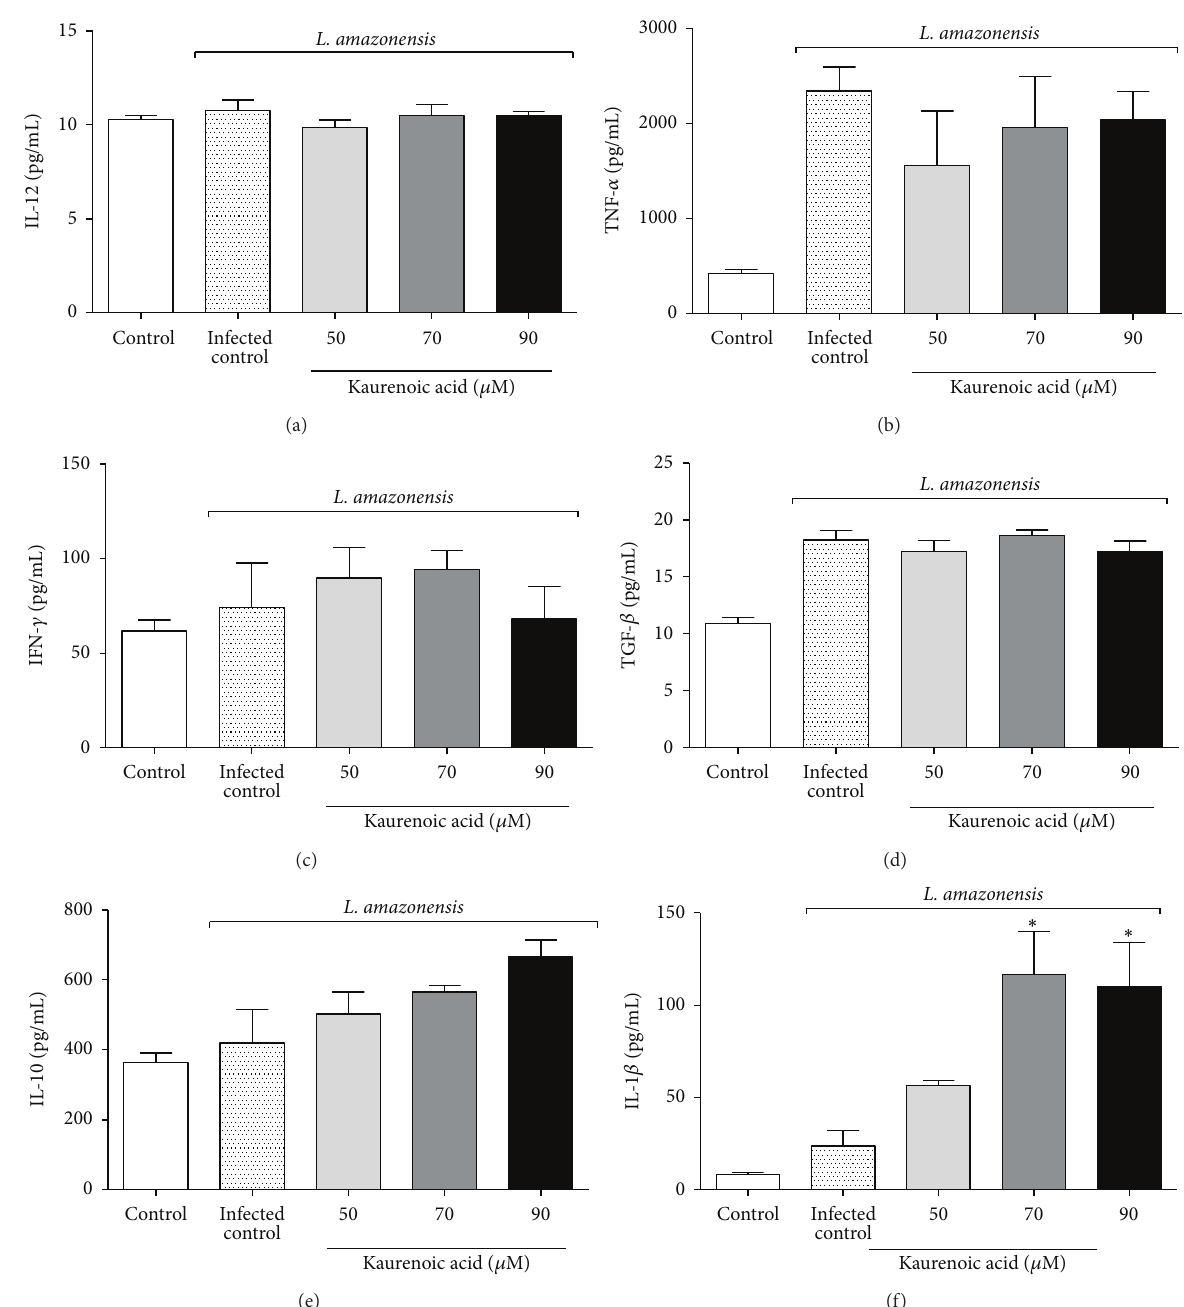
Figure 4: Kaurenoic acid promotes the production of active IL-1 𝛽 in macrophages infected with L. amazonensis . Mapping the cytokine profiling produced in vitro by macrophages infected with L. amazonensis and treated with kaurenoic acid (50, 70, and 90 𝜇 M) for 24 h determined by ELISA. IL-12 production (Panel (a)), TNF- 𝛼 production (Panel (b)), IFN- 𝛾 production (Panel (c)), TGF- 𝛽 production (Panel (d)), IL-10 production (Panel (e)), and IL-1 𝛽 production (Panel (f)). Data represent the mean ± SEM of three independent experiments. ( ∗ Significantly different from infected cells ( 𝑃 < 0.05 ) (one-way ANOVA followed by Tukey’s test).)